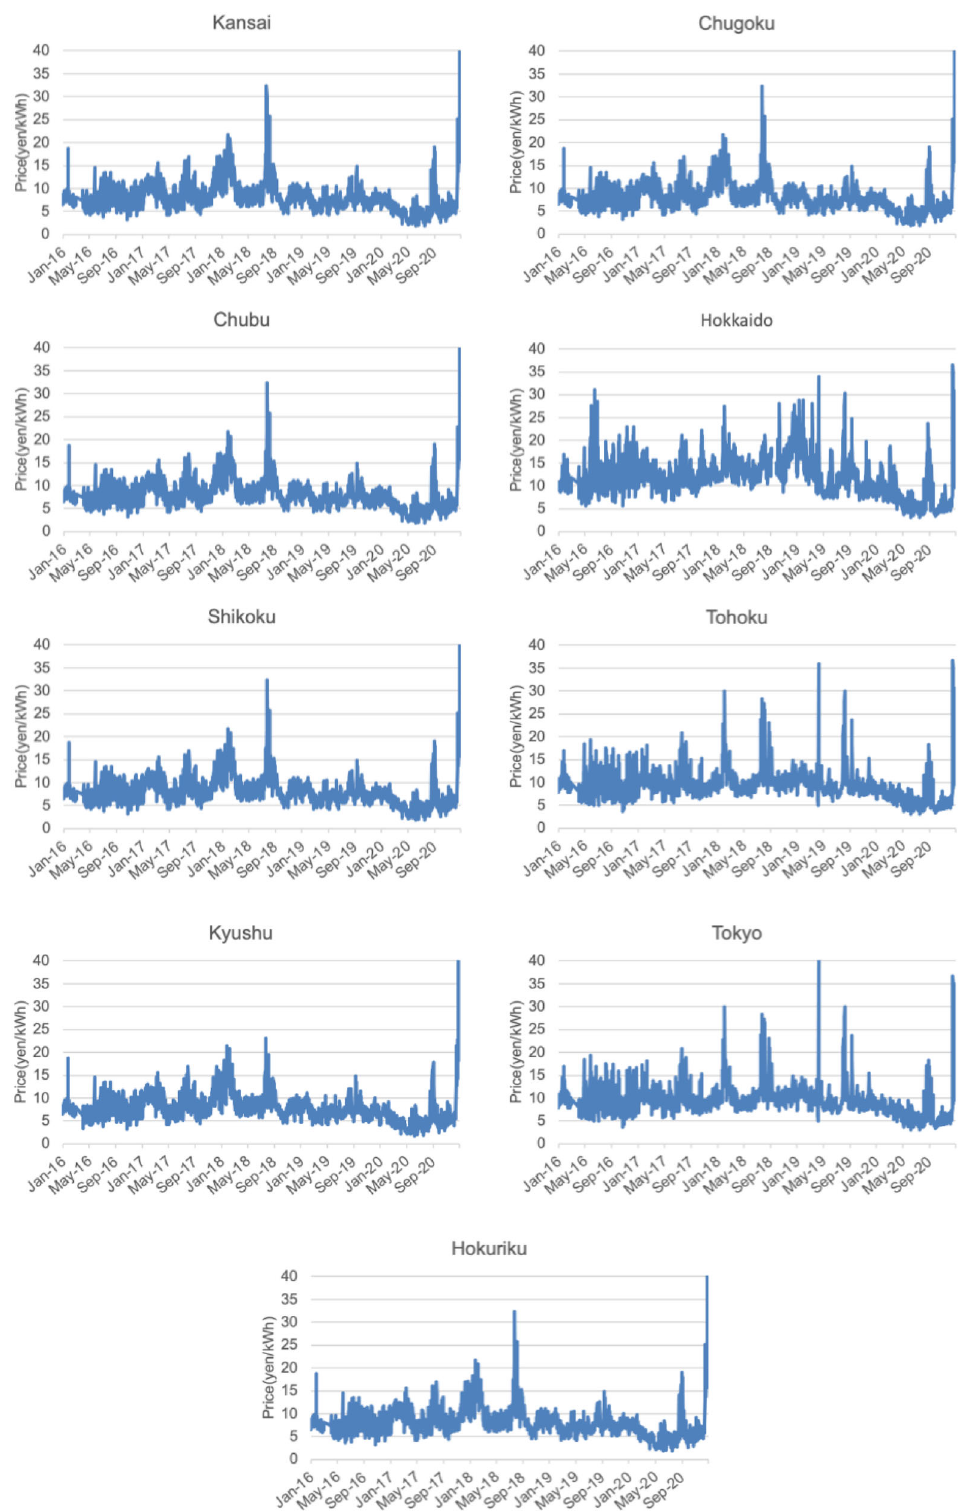
Fig. 1 Daily volume-weighted spot electricity price from 1 January 2016 to 31 December 2020. From the top left to the bottom right are variations of the electricity price for regions of Kansai, Chugoku, Chubu, Hokkaido, Shikoku, Tohoku, Kyushu, Tokyo, and Hokuriku.